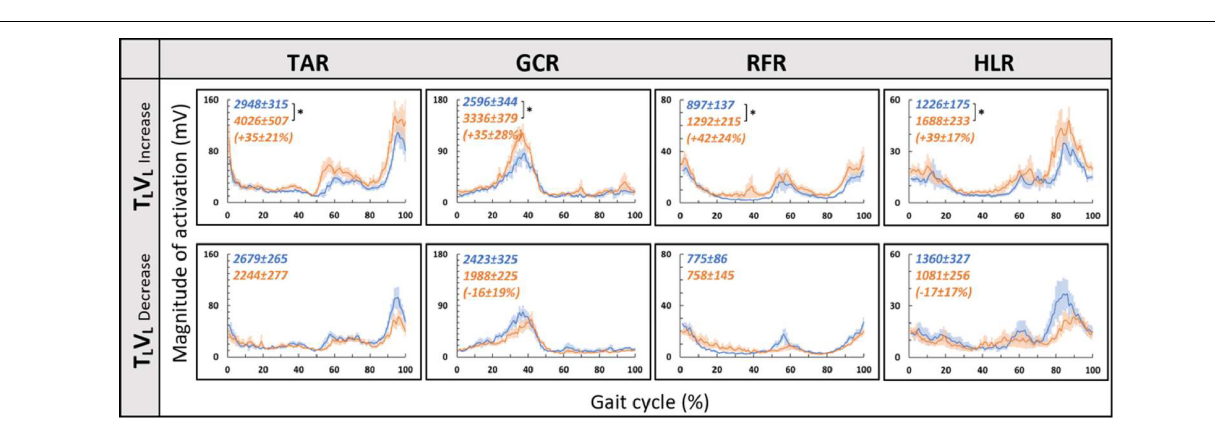
FIGURE 7 | Gait speed does not affect muscle activation patterns for leveled treadmill inclination. Conventions as in Figure 4 , * p < 0.0125. Blue lines represent the activity pre-change, and the orange lines represent post-change (increase by ∼ 15% or decrease by ∼ 20% from